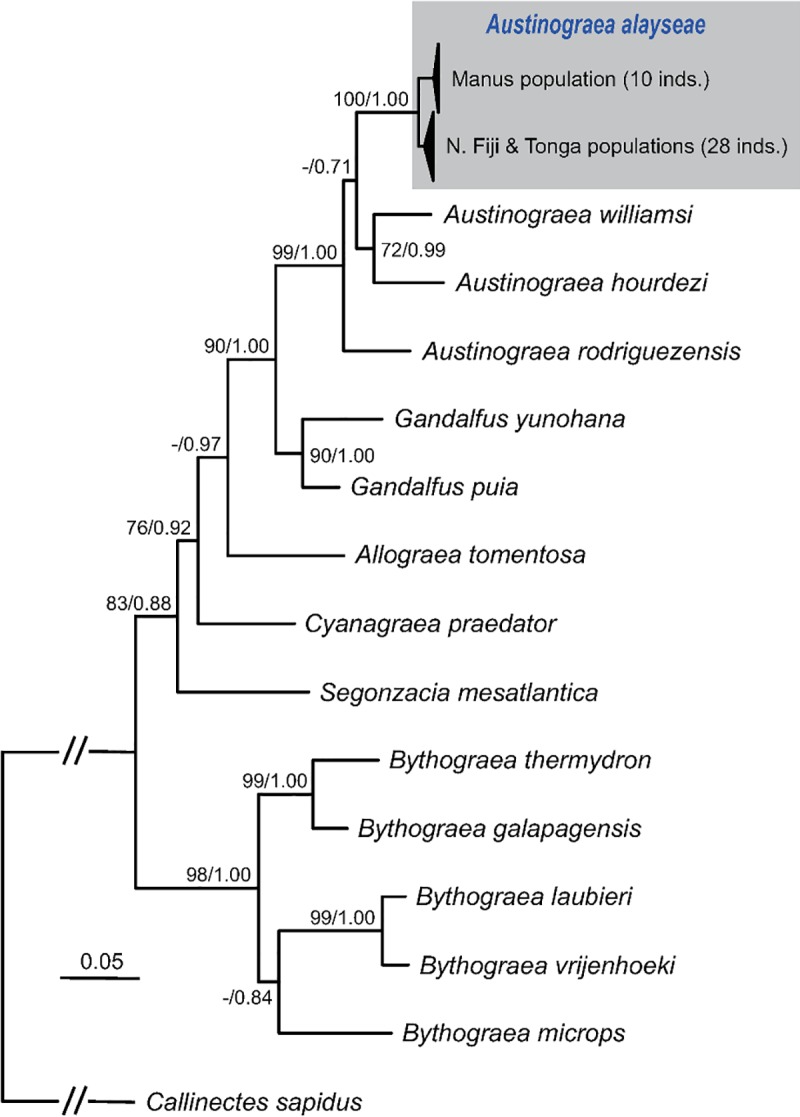
Phylogenetic tree of bythograeid crabs, constructed using a concatenated dataset of COI, 16S rRNA, and 28S rRNA genes.The gray-shaded box highlights three Austinograea alayseae populations. Numbers at internodes are the maximum likelihood bootstrap proportions (left) and Bayesian posterior probabilities (right). Asterisks indicate bootstrap values <60%.